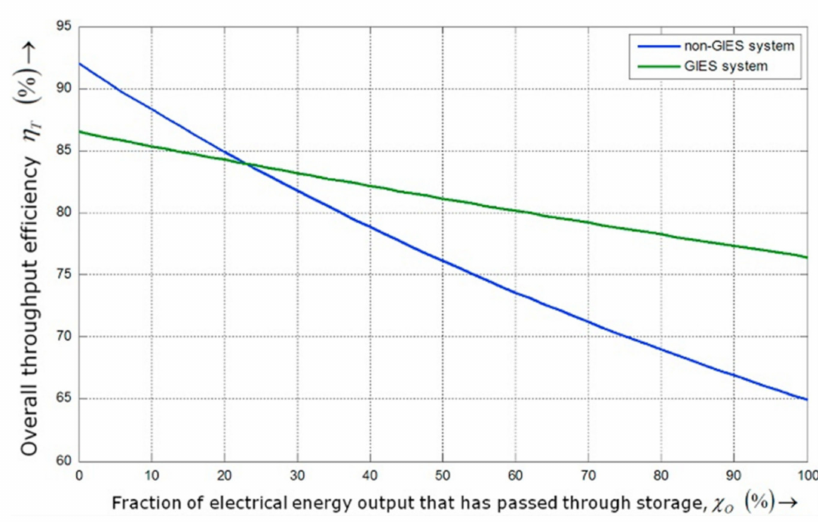
Figure 2. Overall throughput efficiency against fraction of output energy that passed through storage for standalone and GIES stores. From